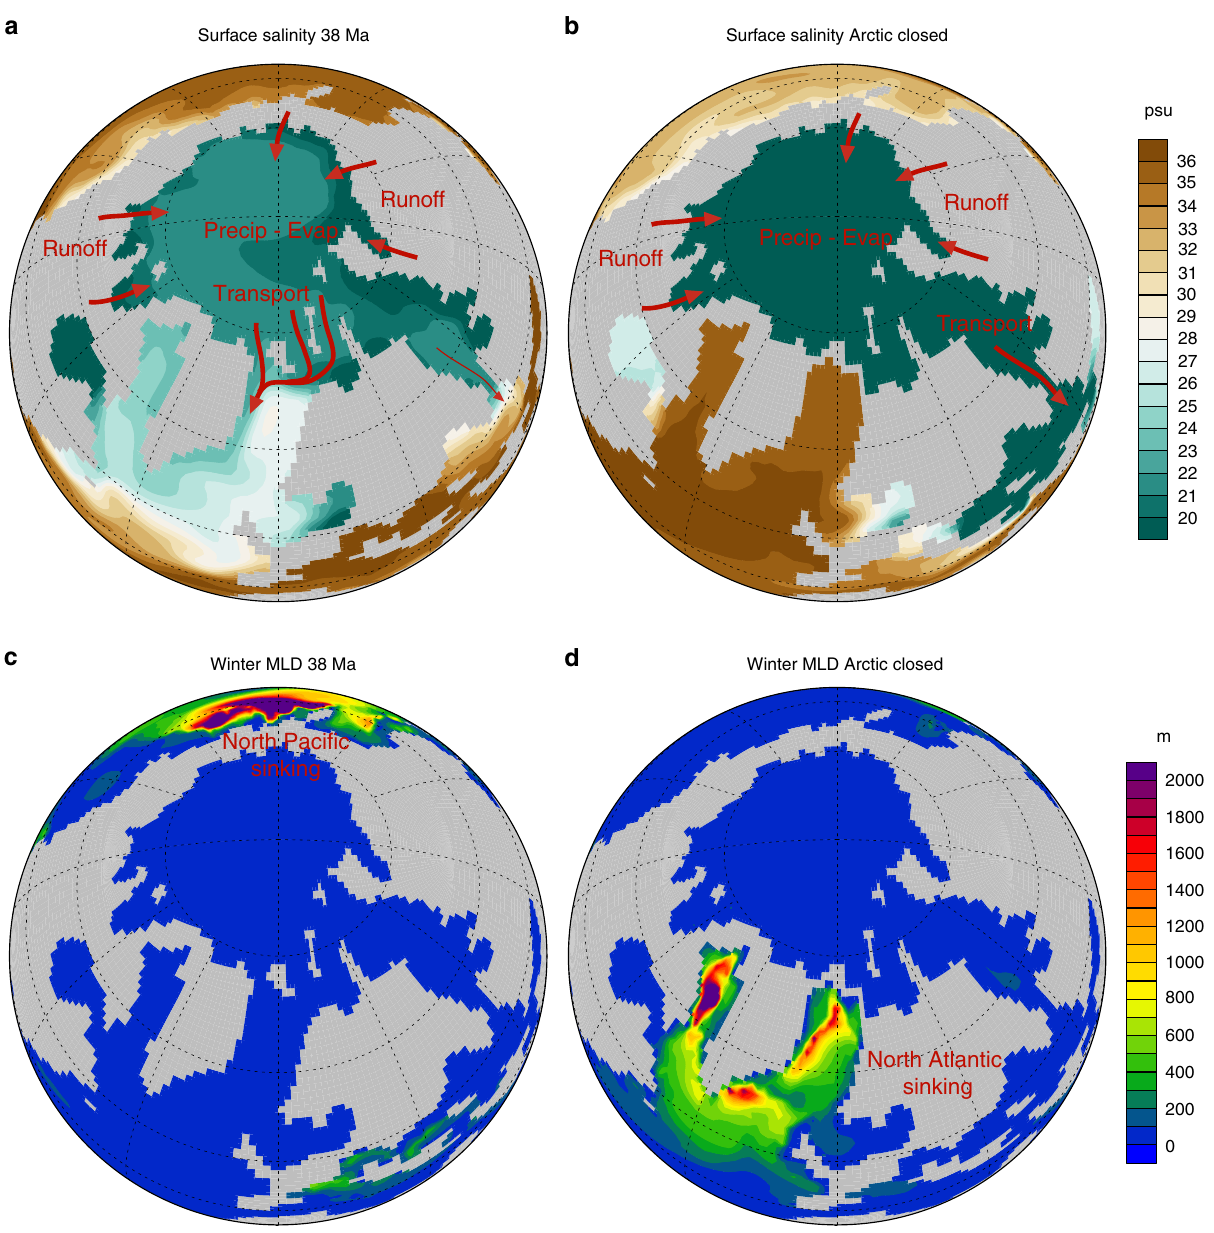
Fig. 2 Surface salinity before and after closure of the Arctic gateway. a Surface salinity in the control run at 38 Ma, b surface salinity with the Arctic – Atlantic gateway closed. c Winter mixed layer depth (MLD) in the 38 Ma control run, and d MLD after closing the Arctic gateway. The Arctic Ocean is very fresh, due to precipitation – evaporation and continental river runoff. Closure of the Arctic – Atlantic gateway leads to a dramatic increase in North Atlantic salinity. This in turn triggers North Atlantic sinking, and the cessation of North Paci fi c